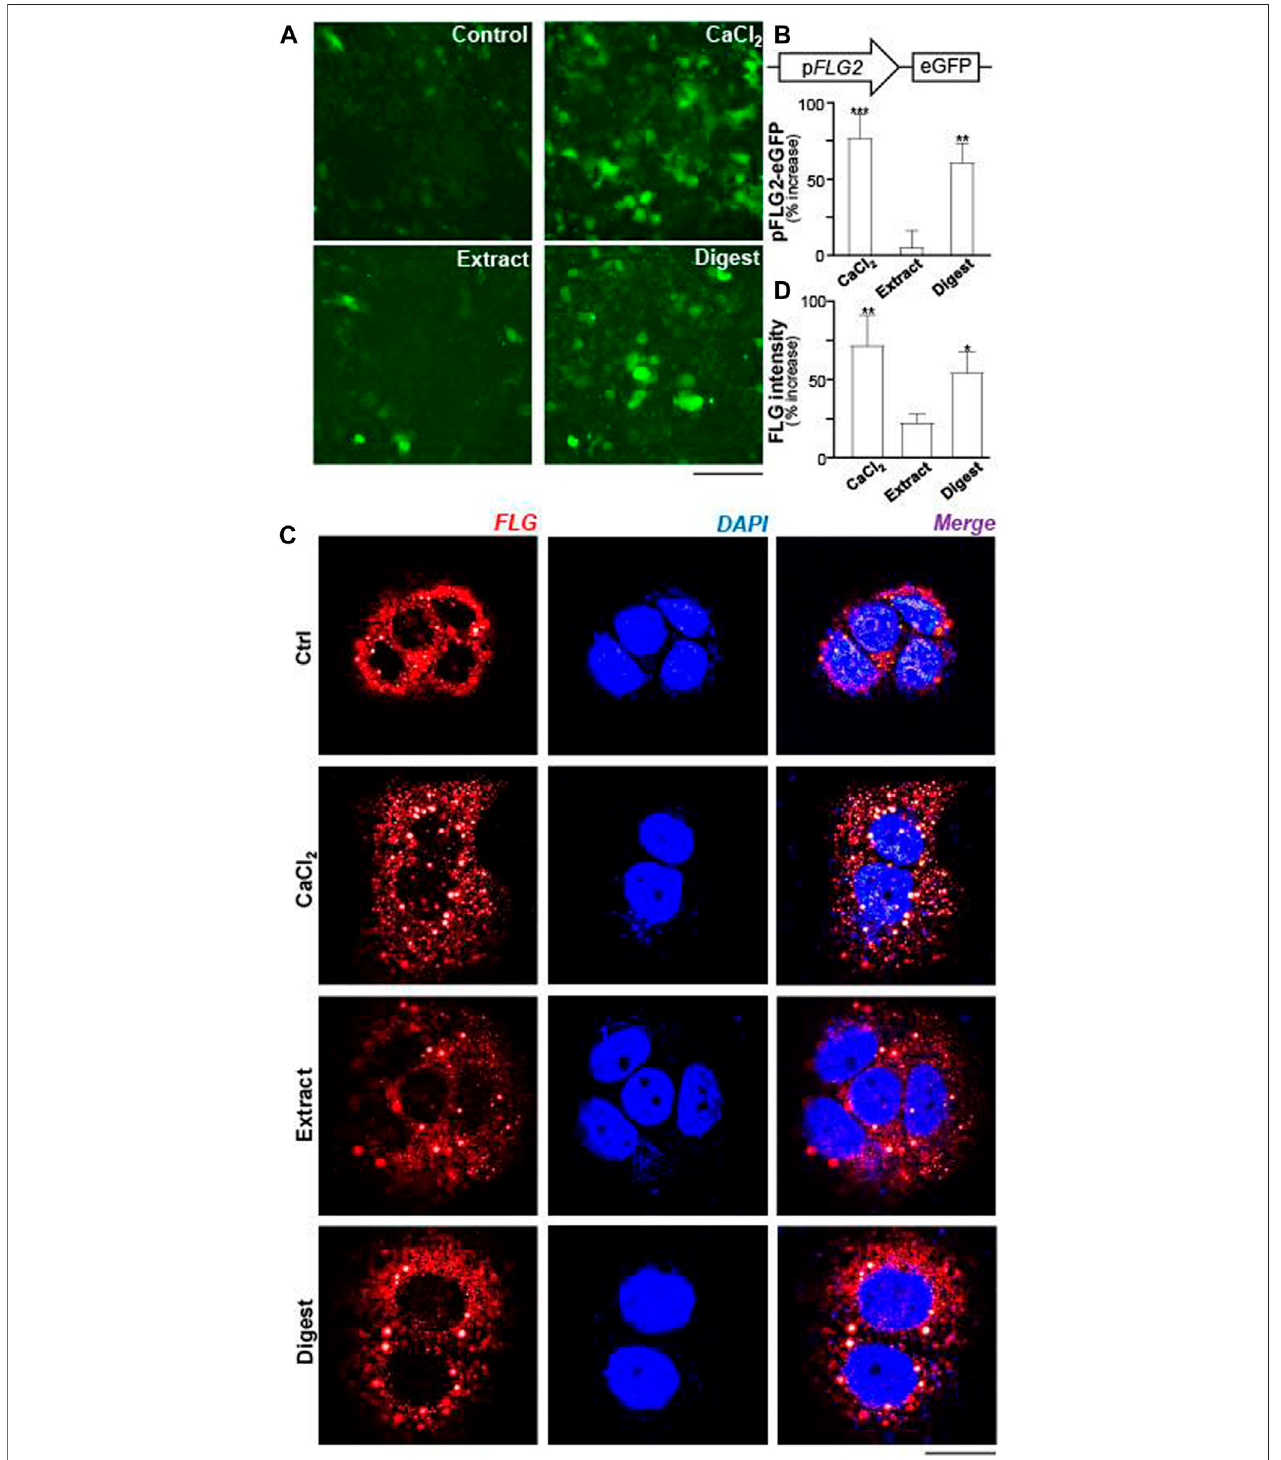
FIGURE 3 | EBNinducestheactivityofpFLG2-eGFPand fi laggrinexpression. (A) The fl uorescenceimagesofpFLG2-eGFPtransfectedkeratinocytesafter24-htreatmentsof CaCl 2 (0.16 mM, a positive control), EBN extract (100 μ g/mL), and EBN digest (100 μ g/mL) are shown, n (cid:2) 3. Bar (cid:2) 100 μ m. The pFLG2-eGFP plasmid was composed of FLG2 promoter tagged with EGFP reporter. (B) The quanti fi cations from (A) are expressed as the percentage of increase in fl uorescence intensity measured under excitation/emission wavelength488/509 nmtonormalizedbasalactivitysetat0inmean ± SEM, n (cid:2) 6.( C) CytosolicexpressionofFLGproteininHaCaTkeratinocytesafter24-htreatmentsofEBN extract (100 μ g/mL) and EBN digest (100 μ g/mL) are shown, in representative confocal images. CaCl 2 at 0.16 mM was adopted as a positive control. n (cid:2) 3. Bar (cid:2) 20 μ m. (D) The quanti fi cationsfrom (C) areexpressedasthepercentageincreasein fi laggrin fl uorescenceintensitytonormalizedbasalactivitysetat0inmean ± SEM, n (cid:2) 3.The fi laggrin fl uorescence intensity of each cell was normalized to total cell area for quanti fi cation. Statistically signi fi cant results are marked with * p < 0.05, ** p < 0.01, and *** p < 0.001 against the control.